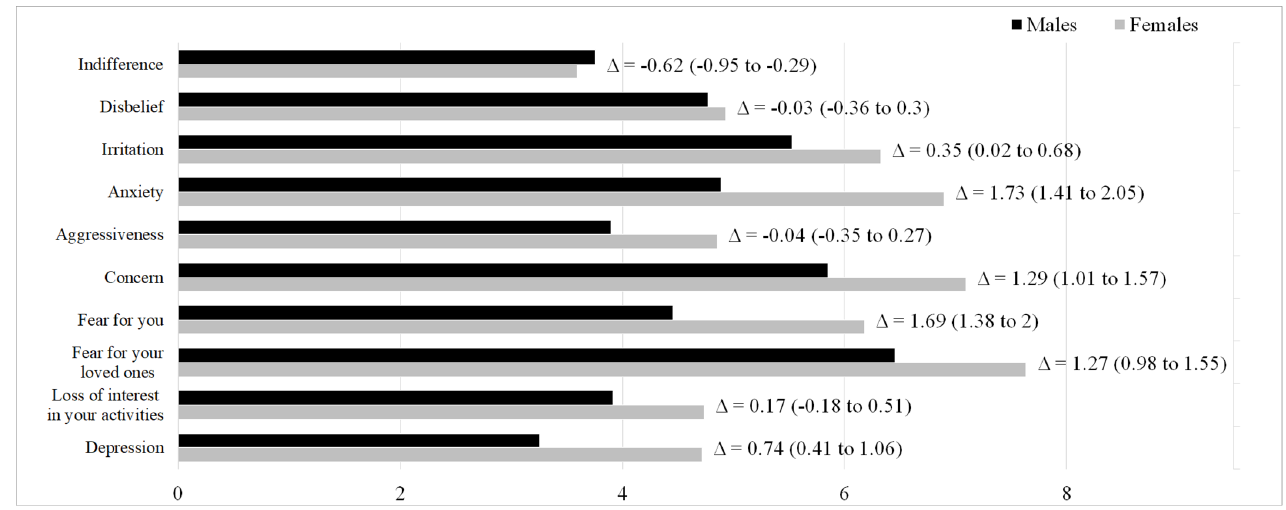
Figure 2. Difference among males and females regarding the 10 questions of the questionnaire in the whole sample (comparison was adjusted by age).